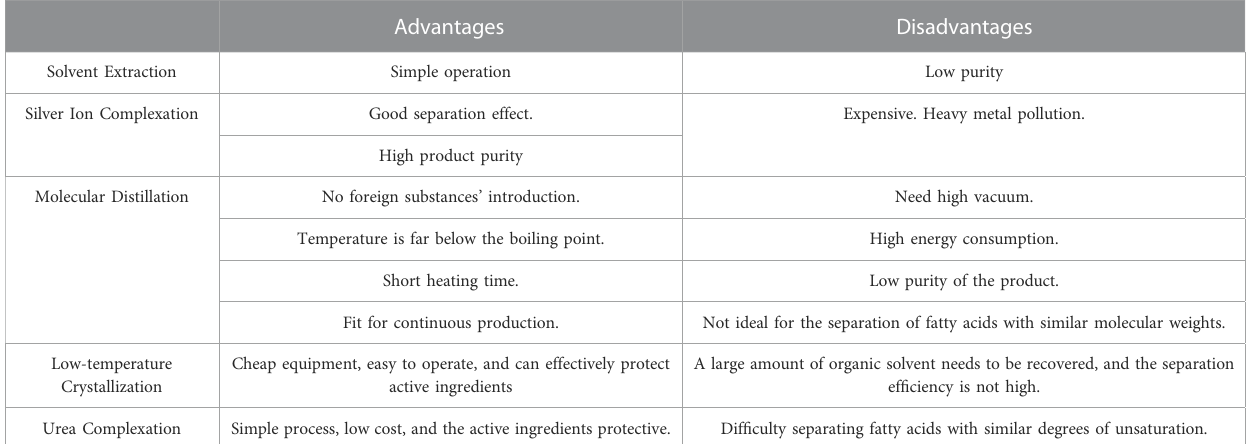
TABLE 6 ALA enrichment